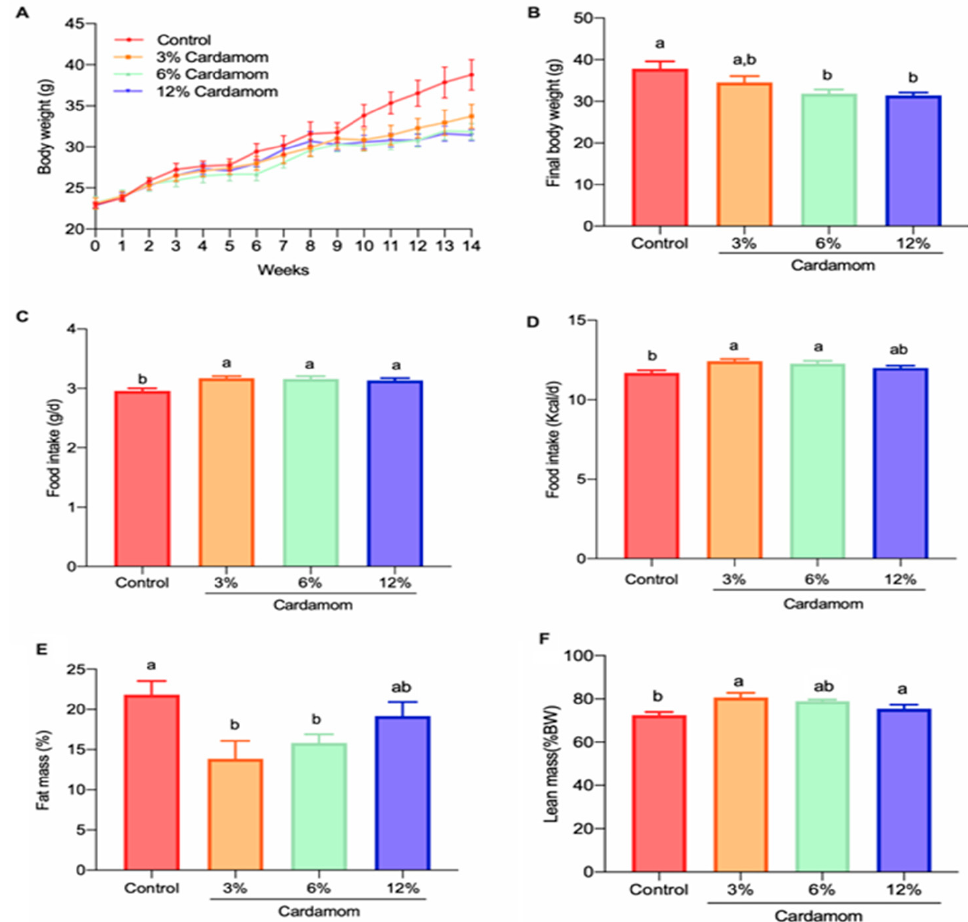
Figure 2. Body weight gain, food intake and body composition of mice fed a control diet or a diet containing 3%, 6% or 12% of Elettaria cardamomum (EC). ( A ) body weight in grams from 0–14 weeks one way repeated measures ANOVA; ( B ) final body weight in grams at week 14; ( C ) mean daily food intake; ( D ) mean daily energy intake in calories; ( E ) percentage of fat mass; and ( F ) lean mass of mice fed with control diet or a diet containing 3%, 6% or 12% cardamom. Data are presented as the mean ± S.E.M., n = 8 mice per group. The differences were considered statistically significant when p < 0.05. Mean values with different lowercase letters show statistical differences between each other.